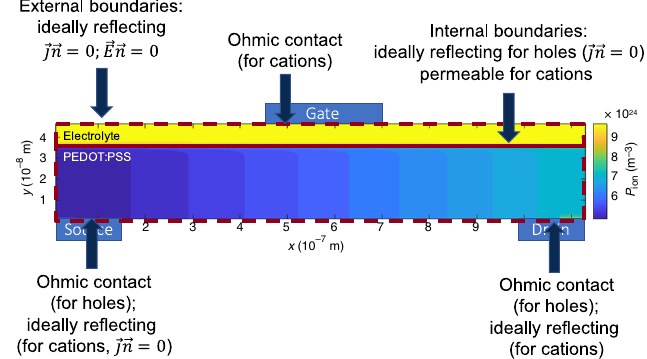
Fig. 5 Setup of 2D OECT model. Drift – diffusion model used to clarify the steady-state behavior of OECTs. The OECT is modeled by a layer of PEDOT:PSS, covered by an electrolyte. The PEDOT:PSS layer is contacted by source and drain electrodes on the bottom, which are treated as Ohmic contacts for holes, but are ideally re fl ecting for ions, that is, the normal ion current is set to zero at the electrodes. The electrolyte is contacted by the gate electrode, which is treated as ohmic for ions, that is, the cation concentration is set to its equilibrium concentration at the interface. Holes can only migrate inside the PEDOT: PSS layer, but cations can migrate inside the electrolyte and PEDOT:PSS. Anions inside the electrolyte and PSS − ions in the PEDOT layer are assumed to be